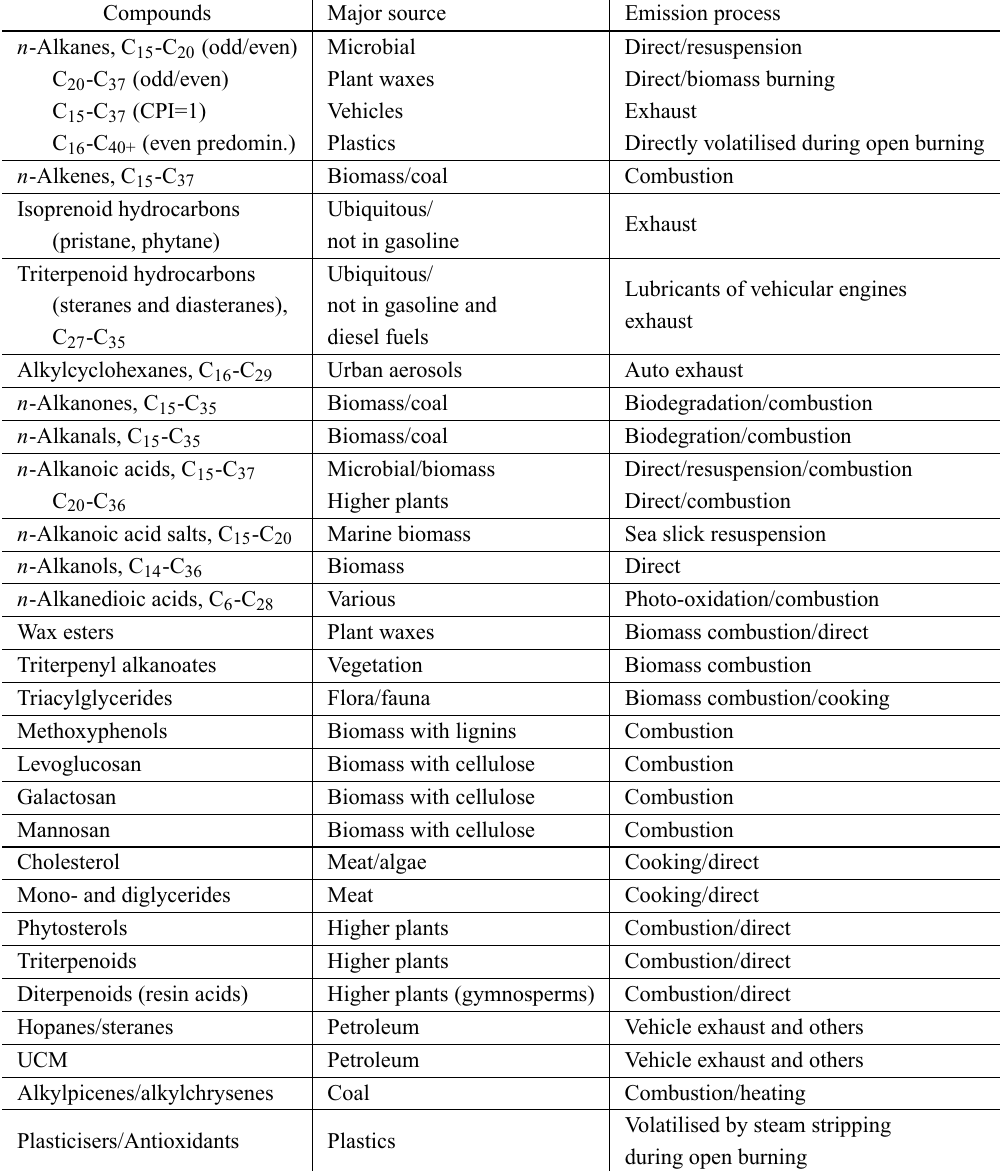
Specific tracers for organic components in atmospheric